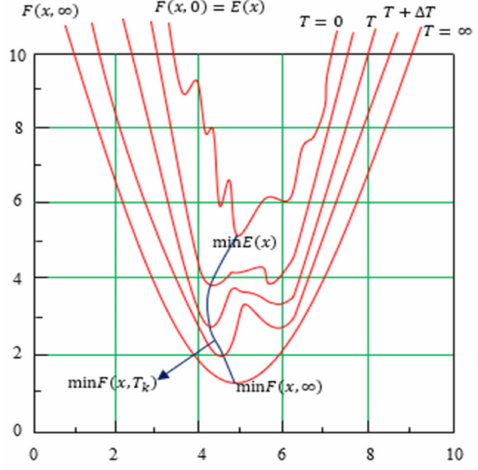
Figure 2. Iterative process of deterministic